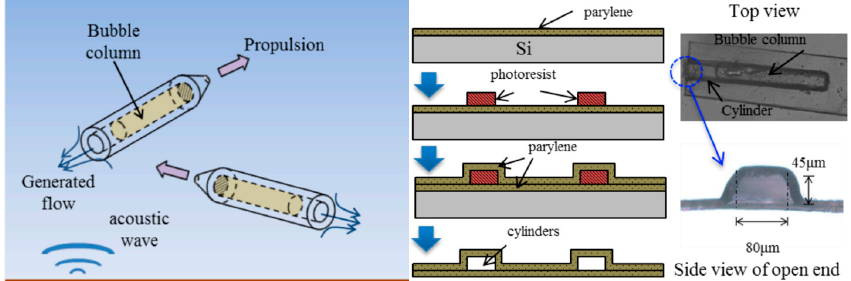
permission from Ref.